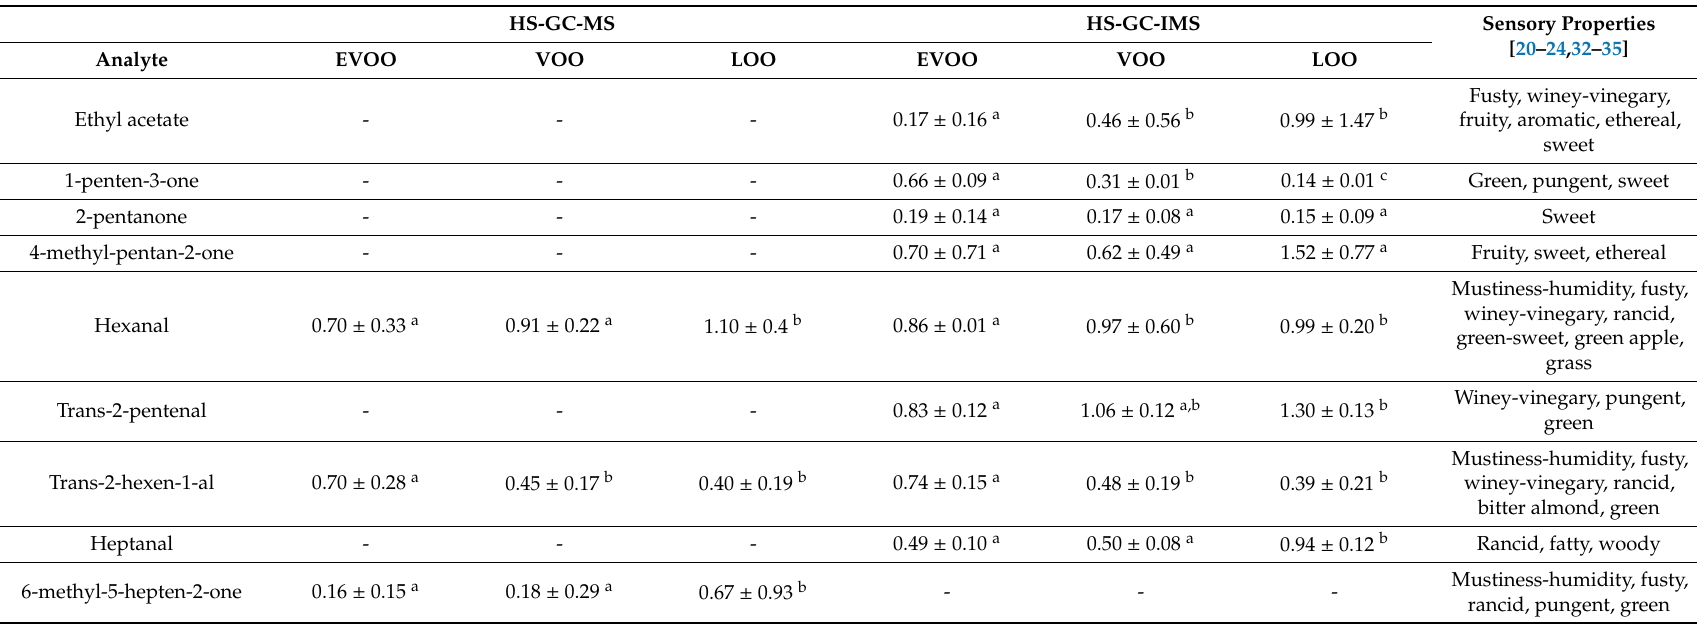
Table 2. Average concentrations ( µ g · g − 1 ) and standard deviation of each analyte including results of the Tukey’s